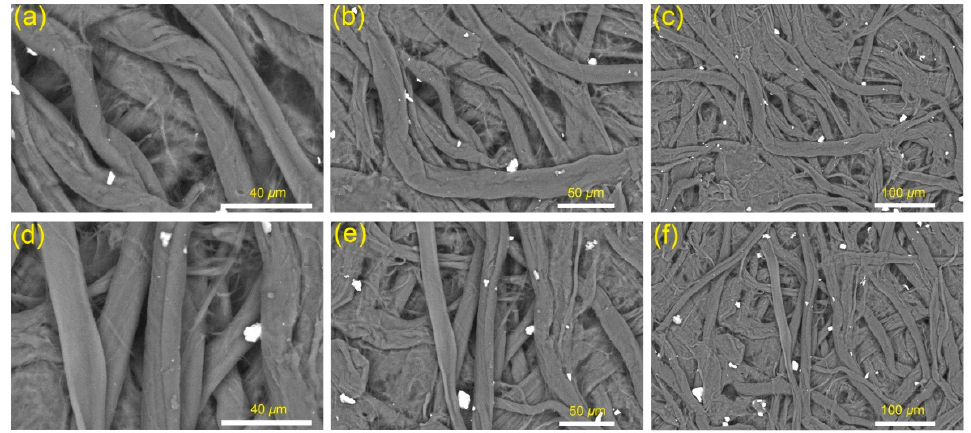
Figure 7. SEM images of hydrazone-immobilized strips before ( a – c ) and after ( d – f ) exposure to cadmium solution. cadmium